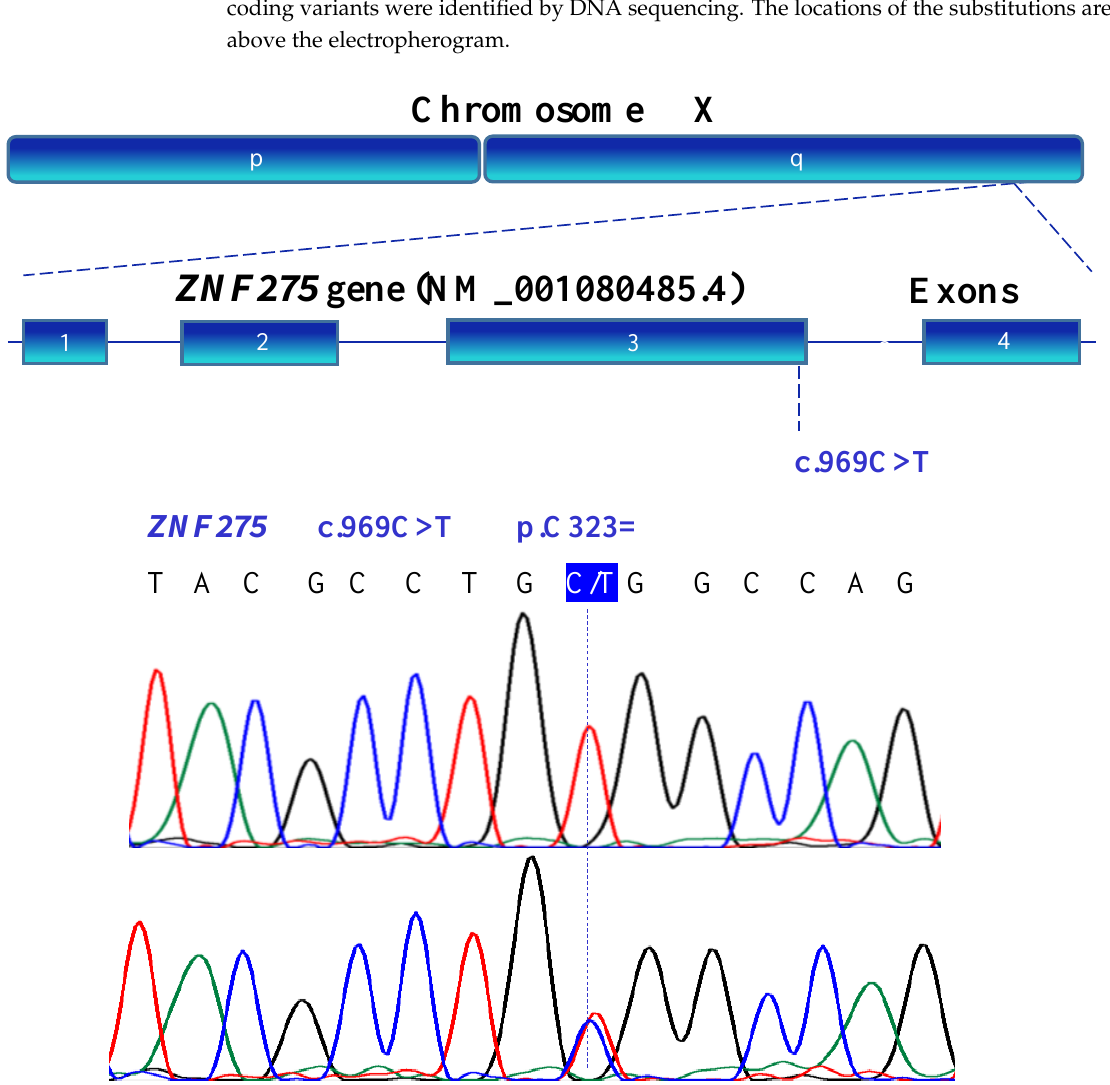
Figure 7. The ZNF275 (NM_001080485.4) gene variant on the long arm of the X chromosome was verified by Sanger sequencing. A homozygous variant (TGT) and heterozygous variant (TGT/TGC) were found in exon 3 (blue